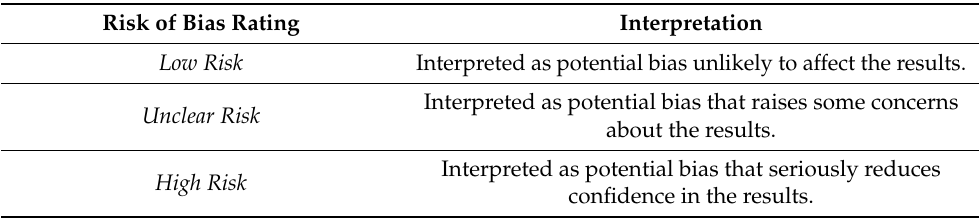
Table 2. Interpretation of Risk of Bias Ratings